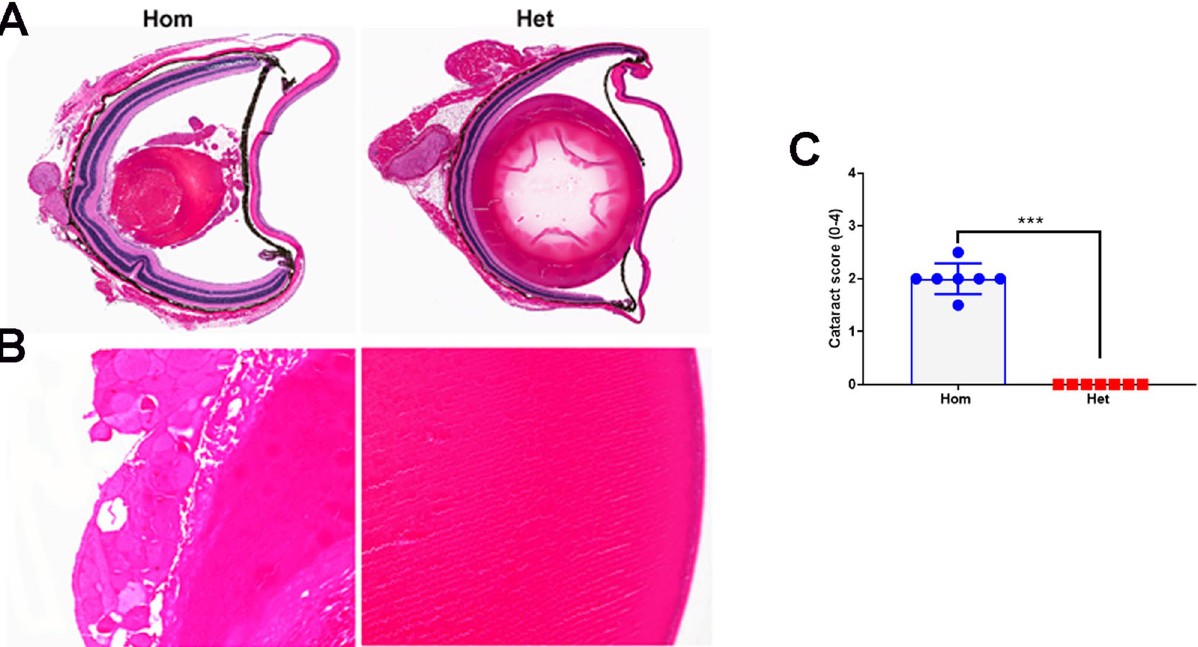
Figure 6. Cataract in Hom mice. ( A ) Note hypermature cataract characterized by collapsed and fragmented lens with the wrinkled capsule and formation of amorphous non-hyalinized core surrounded by protein globules in a Hom mouse as compared to the Het mouse. H&E stain. 1×. Higher magnification of lens showing disorganized, fragmented, and swollen lens fibers forming Morgagnian globules and hypereosinophilic